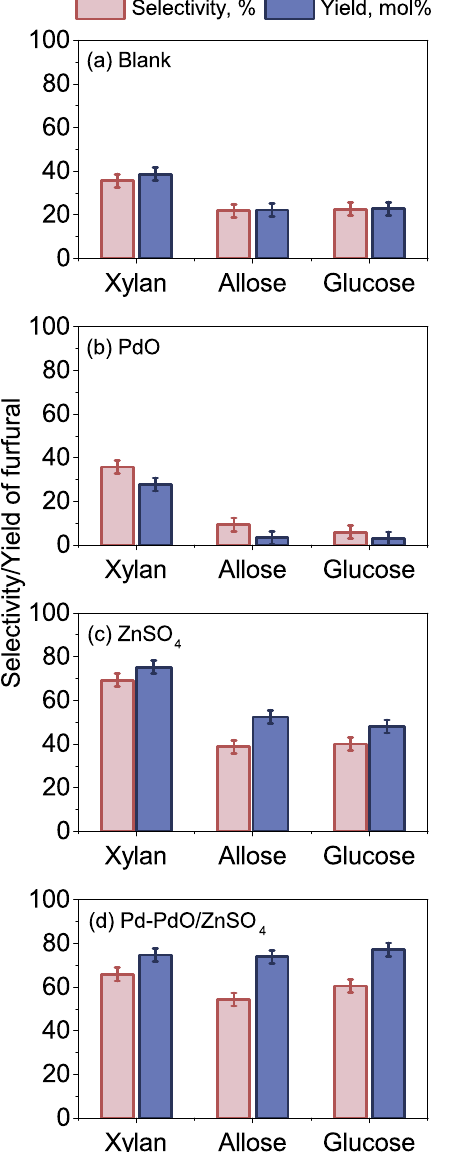
fromtheZnSO 4 catalyst.Panels d and d ’ fortheresultsfromthePd-PdO/ZnSO 4 .All thecatalystsweretestedatamassratioofeighttothefeedstock,andtheerrorbars were based on the standard deviation of the results from more than three